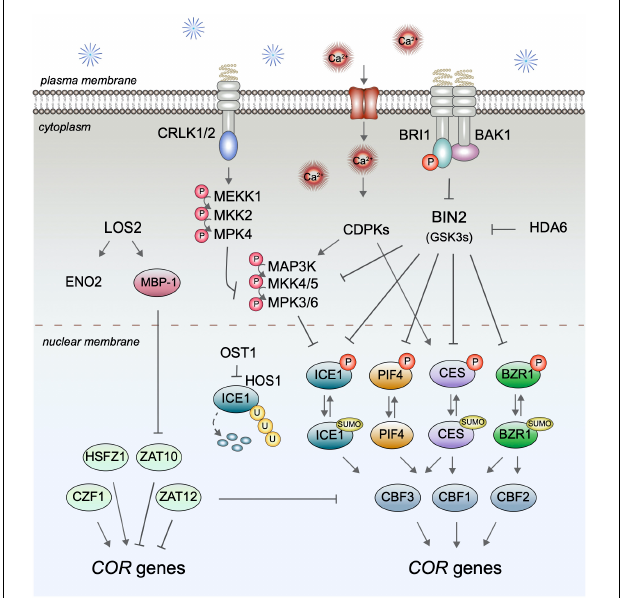
FIGURE 3 | BR signaling and its impact on CBF expression. In the presence of BRs, BRI1 binds to BAK1, to activate inhibition of BIN2-type kinases and thereby impair the phosphorylation and inactivation of the transcription factors ICE1, PIF4, CES, and BZR1 that control expression of specific CBFs . Cold may impact this pathway by multiple means, including effects of calcium-activated CDPKs, CRLK1/2-controlled MAP kinases, and cold-induced SUMOylation events. In addition to CBF -control, BR signaling also impacts CBF-independent modes of COR gene regulation, our understanding of which is summarized on the left. However, how this activity is realized is yet